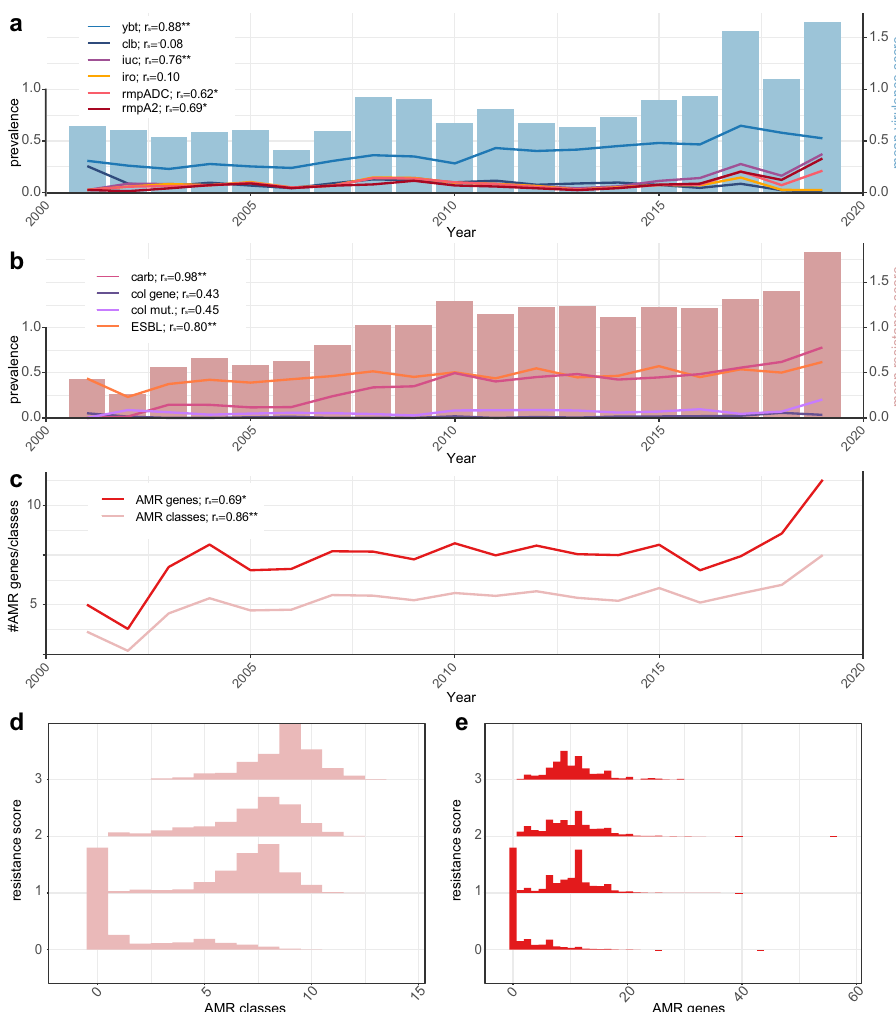
Fig. 1 Relationships between Kleborate virulence and resistance scores and the prevalence of key virulence and antimicrobial resistance (AMR). Data shown summarize Kleborate results for non-redundant set of 9705 publicly available K. pneumoniae genomes (Supplementary Data 2). a Barplot shows mean virulence score per year (right y -axis), line plots show the prevalence of individual virulence loci per year (left y -axis). Ybt yersiniabactin, clb colibactin, iuc aerobactin, iro salmochelin, rmpADC hypermucoidy rmp locus, rmpA2 rmpA2 gene. Spearman correlation coef fi cients ( r s ) between the mean virulence score and prevalence of each locus are noted. P values from two-sided statistical testing: ybt = 2.2 × 10 − 16 , clb = 0.74, iuc = 0.0002, iro = 0.68, rmpADC = 0.005, rmpA2 = 0.002. b Barplot shows mean resistance score per year (right y -axis) and line plots show the prevalence of carbapenemases (carb), acquired colistin resistance genes (col gene), mutations in MgrB/PmrB (col mut) and genes conferring resistance to extended-spectrum β -lactams (ESBL) (left y -axis). Spearman correlation coef fi cients ( r s ) between mean resistance score and prevalence of each resistance type are noted. P values: carb = 8.3 × 10 − 6 , col gene = 0.06, col mut = 0.05, ESBL = 5.56 × 10 − 5 . c Mean number of acquired AMR genes and classes, over time. Spearman correlation coef fi cients with mean resistance score are noted. P values: AMR genes = 0.001, AMR classes = 2.2 × 10 − 16 . d Histograms showing total number of acquired AMR classes predicted per genome, strati fi ed by resistance score. e Histograms showing a total number of acquired AMR genes detected per genome, strati fi ed by resistance score. Spearman correlation coef fi cients are shown in a-c; signi fi cance levels are indicated with asterisks: * p < 0.01, ** p <